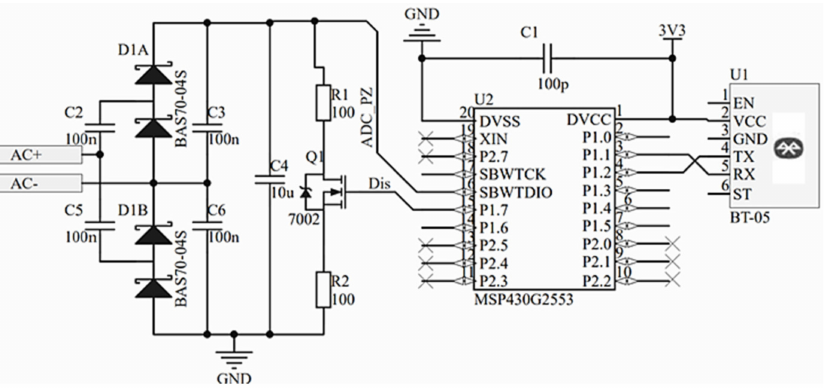
Figure 8. Electrical schematics of the prototype PCBA used with designed